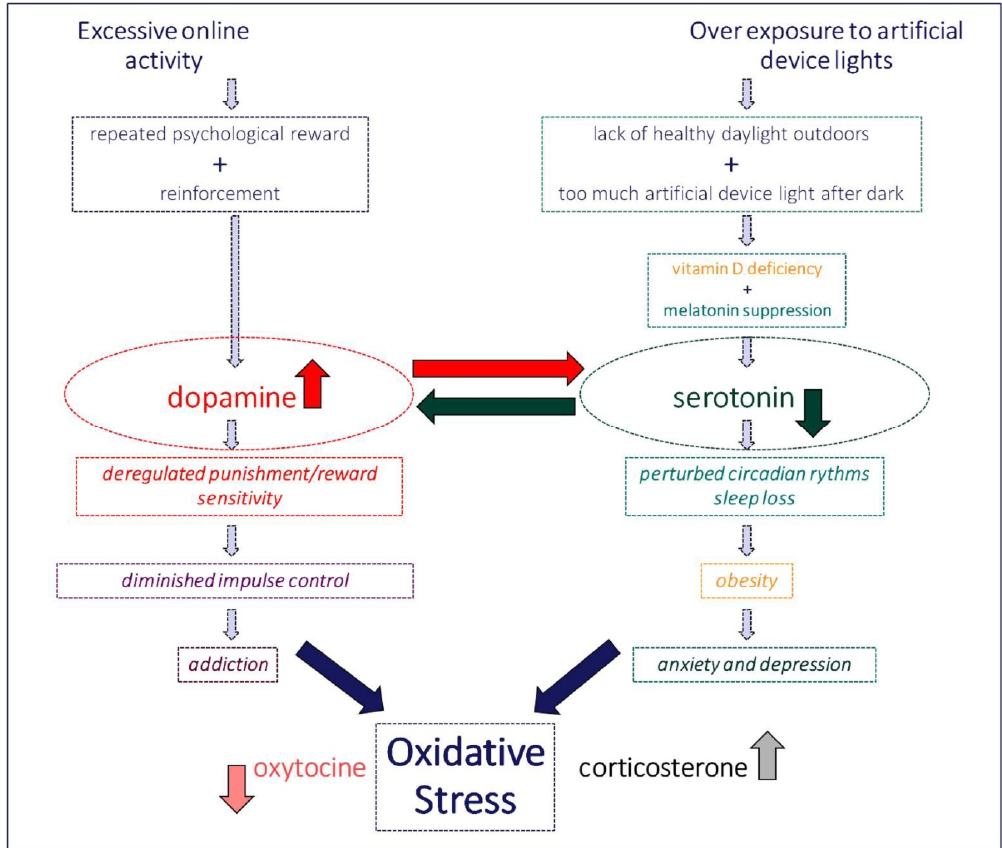
Figure 6. Excessive online activity and, ultimately, digital addiction inevitably go along with an over exposure to artificial device lights. Each of these two produces clearly identified changes in